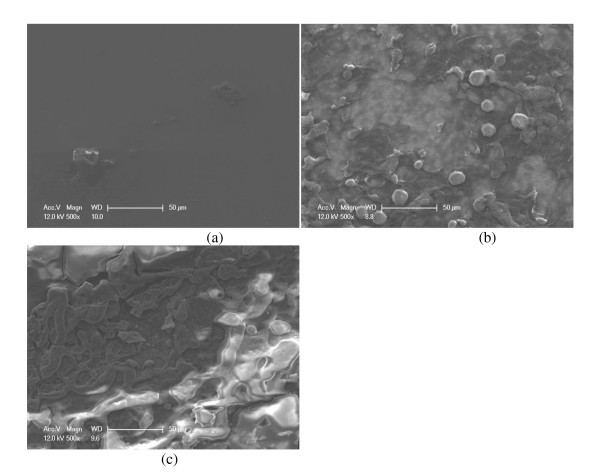
SEM images (× 500) of ITO heater surface. After boiling in (a) DI water, (b) 0.01 vol.% diamond nanofluids, and (c) 0.1 vol.% silica nanofluids.